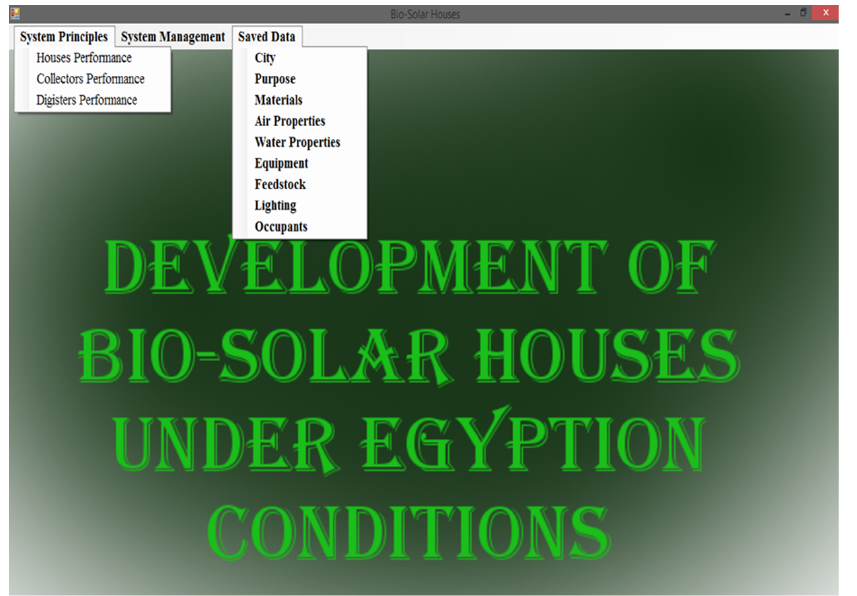
Figure 3. The program’s main working interface.